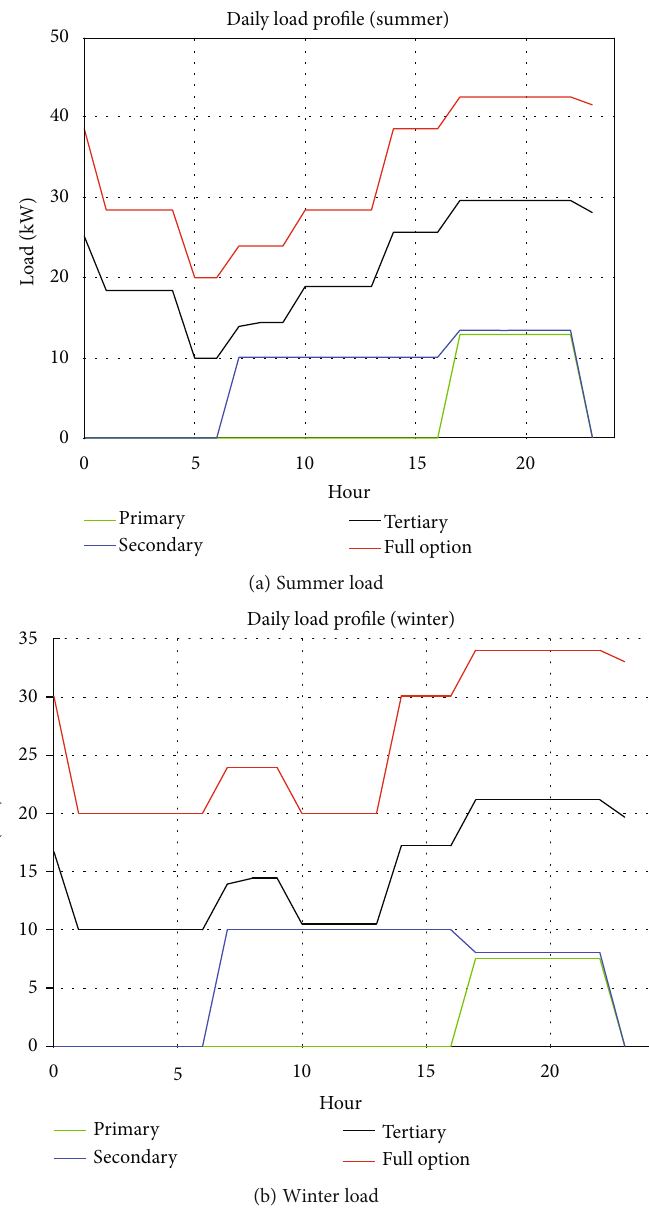
Figure 5: Daily load pro fi le for all four